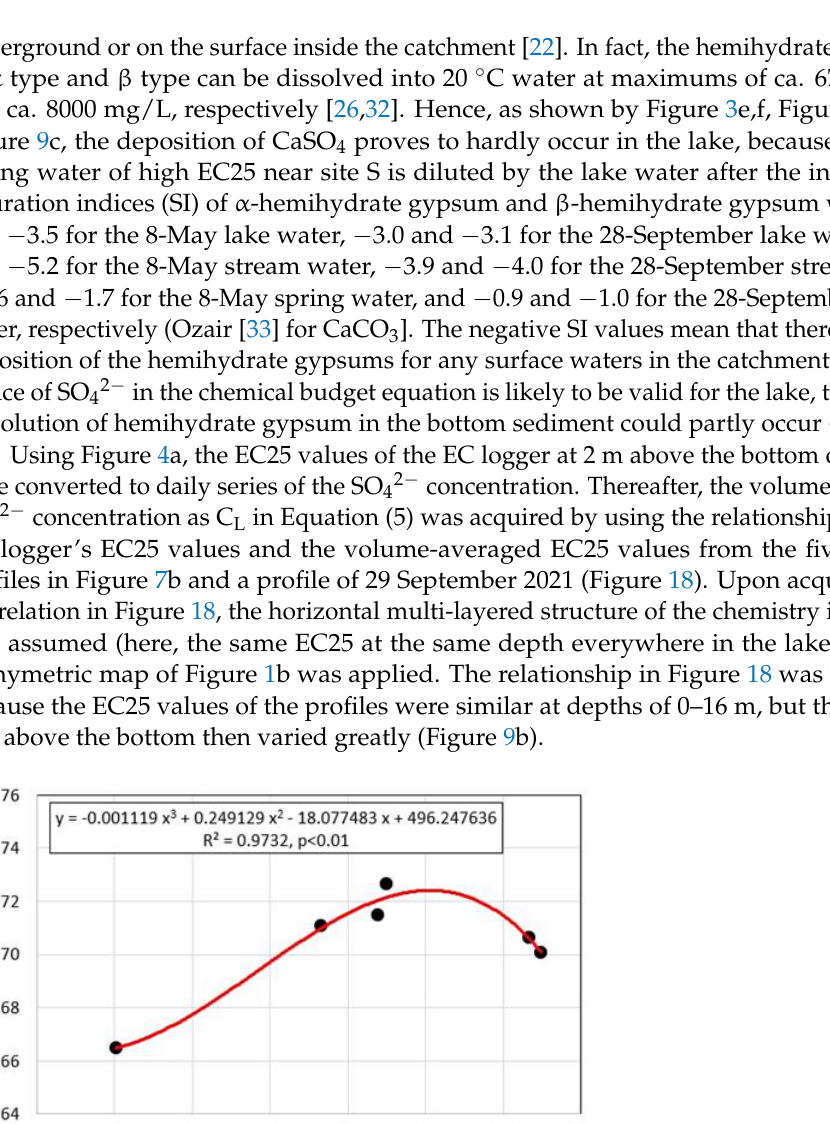
Table 1. Measured mean lake level, calculated net groundwater inflow (G in − G out ), and separated groundwater inflow G in and groundwater outflow G out for the non-rainfall periods of more than three days in 2020 and 2021.